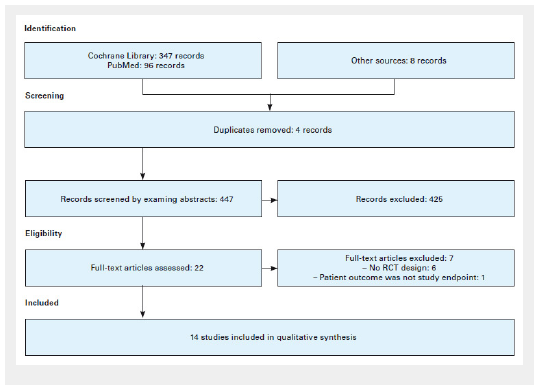
Flow diagram on phases of review process (according to PRISMA statement